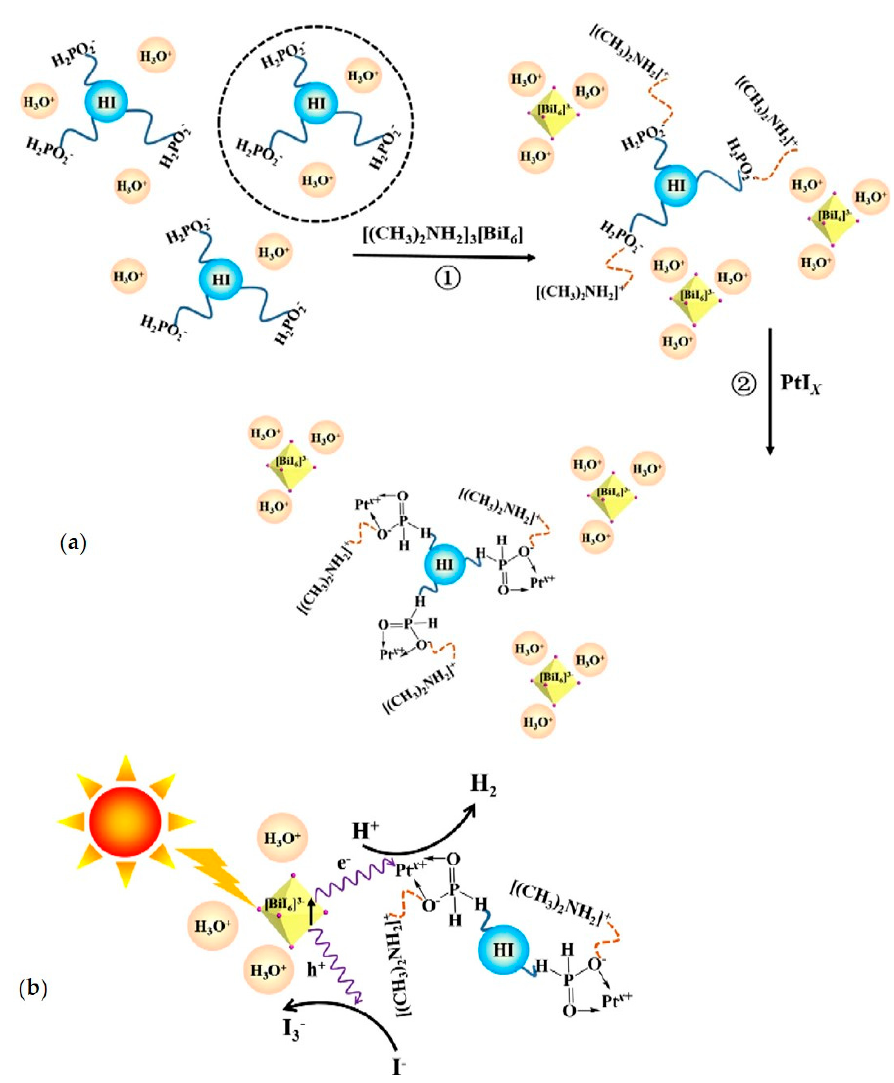
Figure 6. Schematic illustration of ( a ) the conversion process in the colloidal HI-H 3 PO 2 aqueous solution and ( b ) the proposed mechanism for the H 2 generation. [(CH 3 ) 2 NH 2 ] + ions correspond to DMA + ones. Reproduced from [31], with permission from Elsevier, 2018.